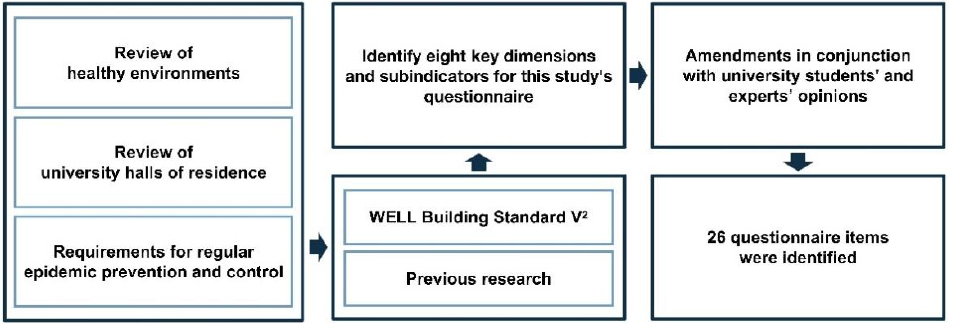
Figure 2. The design logic of the selection process of 26 research variable items.